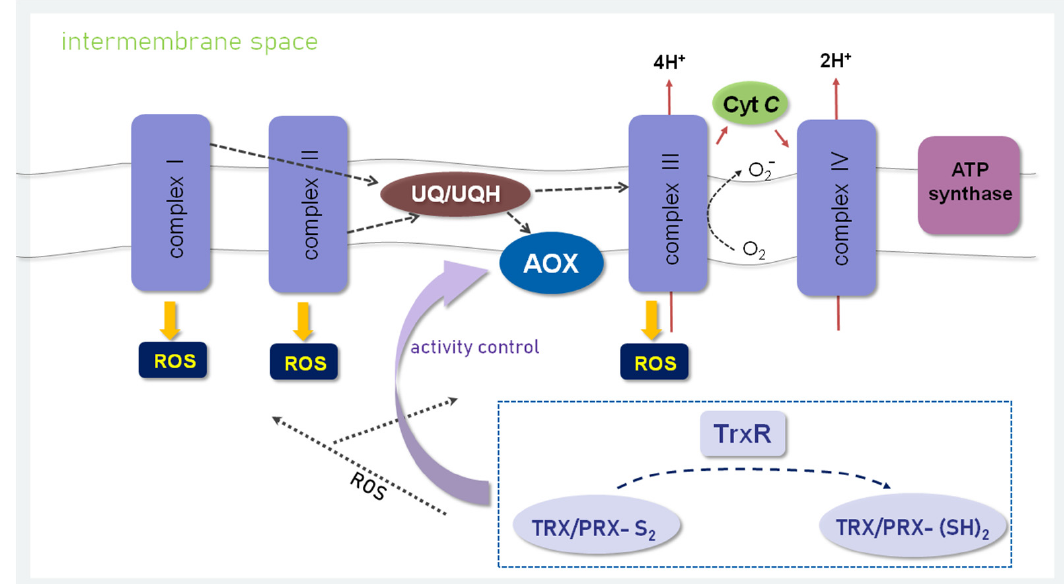
Figure 3. During long-term seed storage, mitochondrial structure is damaged in seeds due to increased ROS levels, oxidative damage to membranes, loss of enzyme activities and reduced activity of the antioxidant system [41]. We hypothesize that, during seed storage, under the influence of ROS, changes in metabolic activity and respiratory electron transport chain initiate the switch to the alternative respiratory pathway. The switch to ubiquinone-linked AOX for electron transport is regulated by mitochondrial TRX, changes in metabolite concentrations and by transcriptional control. During long-term seed storage, a decrease in the activity of systems regulating the redox state of cells is observed. The level of thiol group-containing proteins, i.e., TRXs and PRXs, mainly decreases [15], i.e., proteins that are actively involved in regulating the level of ROS and in modulating redox signaling. The decrease in the activity of TRX and PRX, on the one hand, likely affects the decrease in AOX activity and disrupts the phosphorylating electron transport and energy production needed by the cell to function properly. On the other hand, the decrease in the activity of TRX and PRX will lower the antioxidant defense, increase the ROS level and enhance mitochondrial dysfunction. The sum of all these events accelerates the aging process and reduces seed